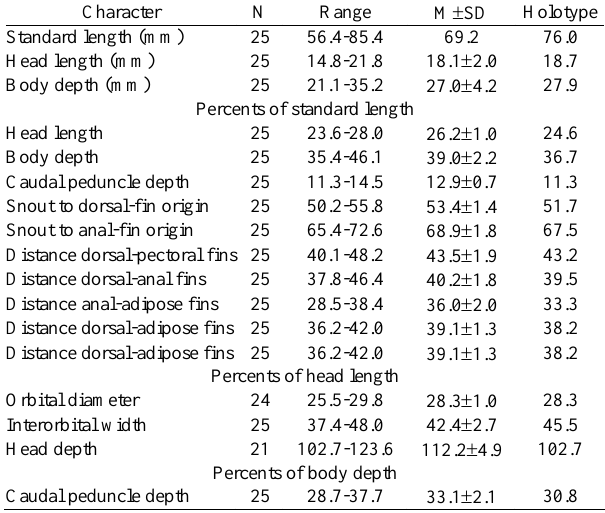
Table 1. Morphometric and meristic data for Astyanax goyacensis Eigenmann, holotype (MCZ 89558) and topotypes (N: number of specimens; M: mean; SD: standard